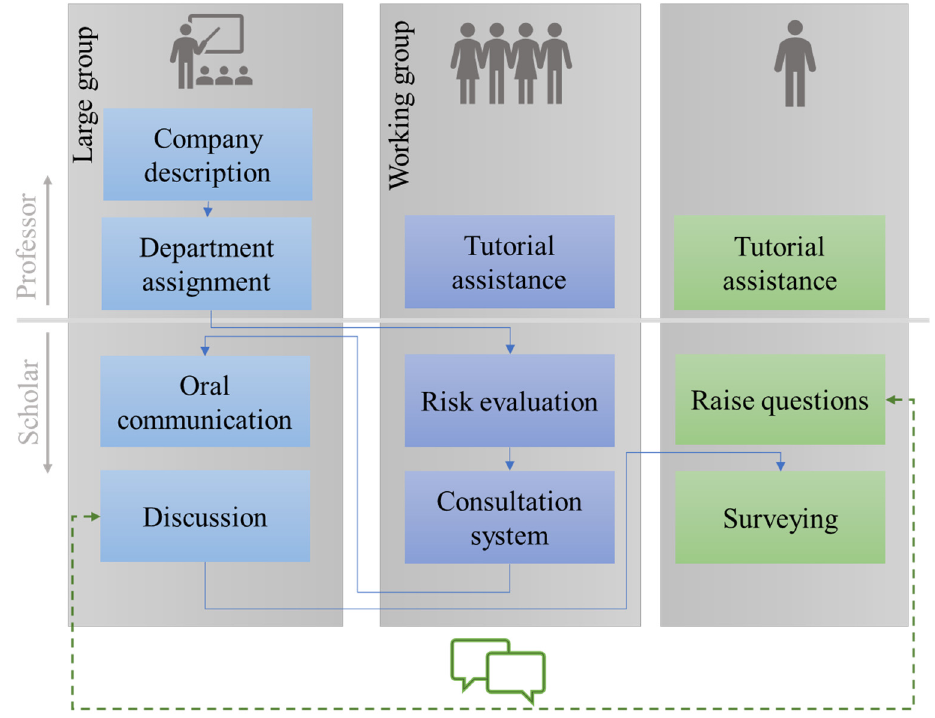
Figure 1. Workflow for the activity development.